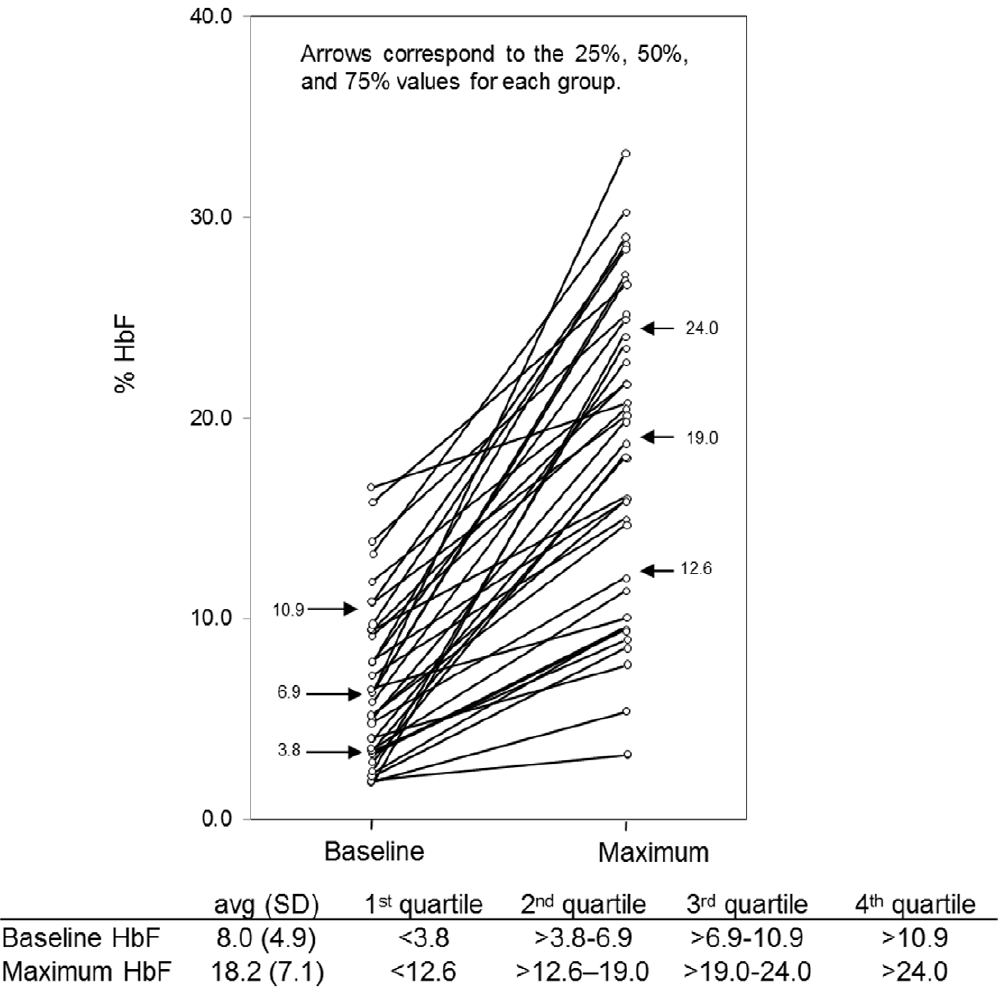
Figure 1. Baseline and hydroxyurea-induced maximum HbF for each subject (comparable to References 18, 19, 26).